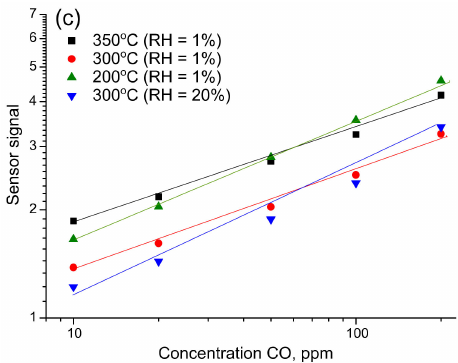
Figure 11. Calibration curves in double logarithmic coordinates for SnO 2 ( a ), SnSi13 ( b ) and SnSi19( c ). By calculating the average resistance value ( R av ) and the standard deviation ( σ ) of resistance in air